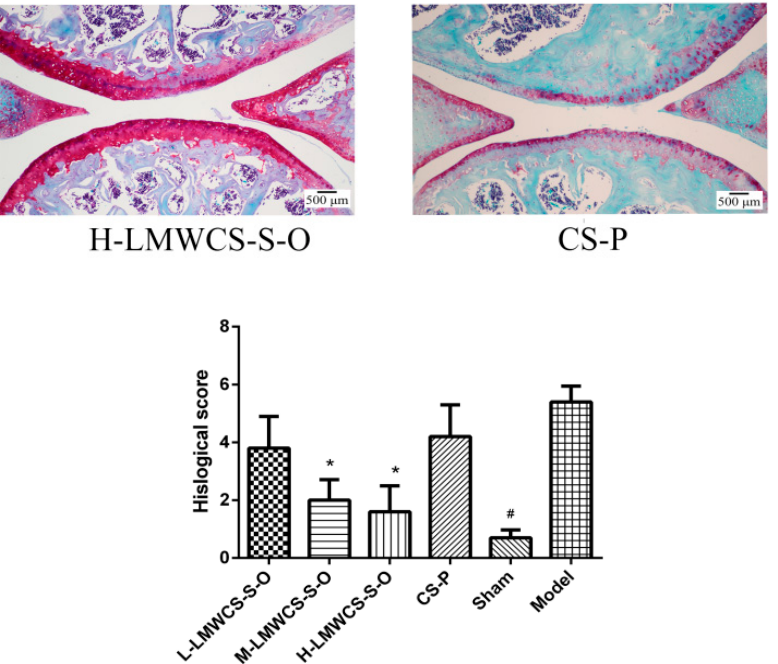
Figure 7. Histological analysis of the joint cartilage and semi-quantitative OA grade analysis. Semi-quantitative OA grade analysis presented in bar graphs ( n ≥ 5). * p < 0.05 vs. the model; # p < 0.05 vs. the model. The L-LMWCS-S-O, M-LMWCS-S-O and H-LMWCS-S-O groups were administered with 50, 150 and 450 mg/kg of LMWCS-S-O, respectively. The CS-P group was administered with 150 mg/kg of CS-P.